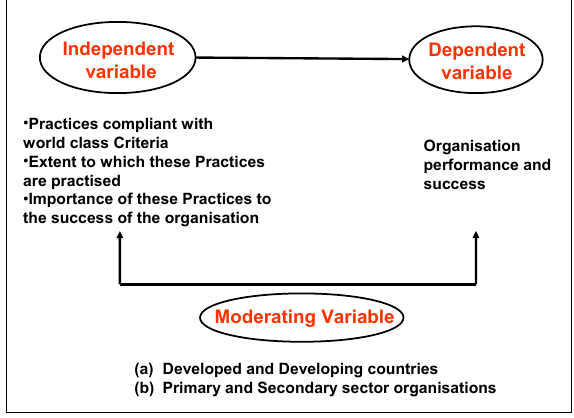
FIGURE 1 Description of the research variables and the relationships between